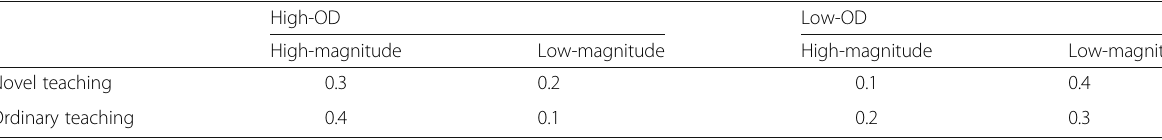
Table 1 Outcome contingencies used in Experiment